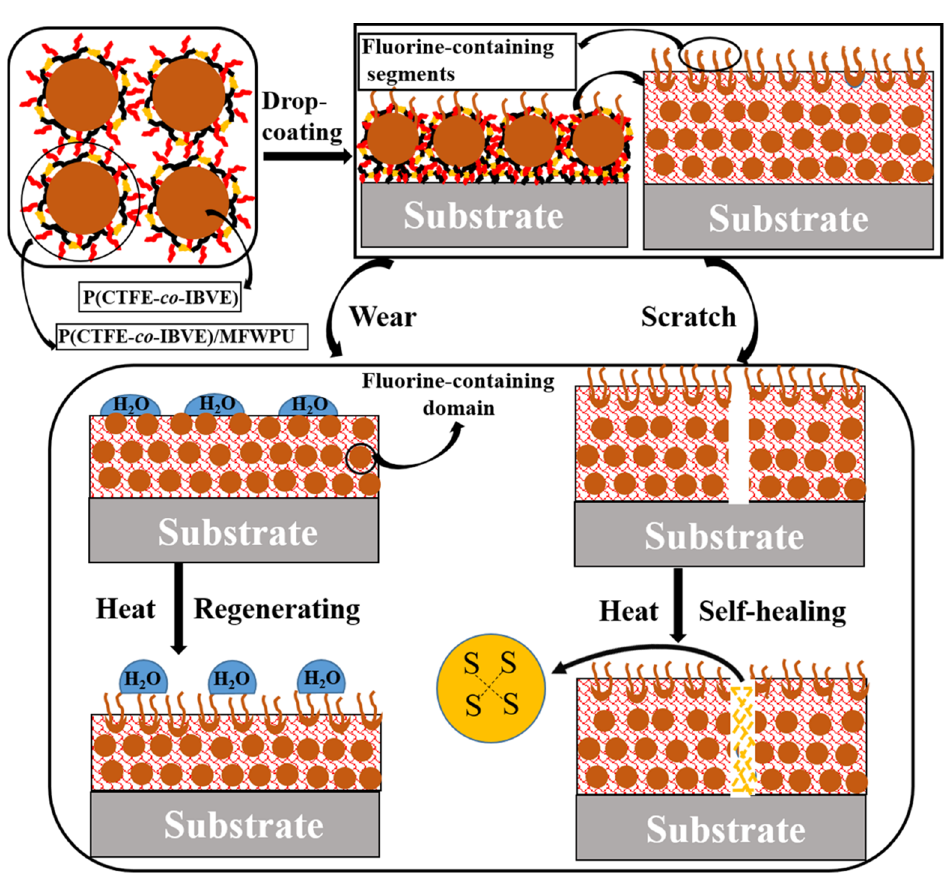
Figure 5. A double self-healing model of P(CTFE- alt -IBVE)/MFWPU composite coating.